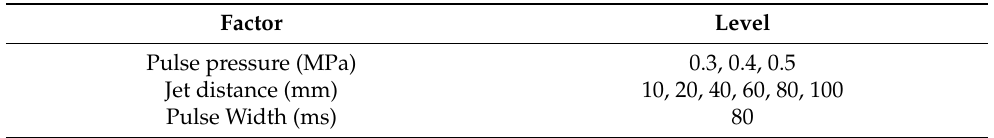
Table 1. Parameter settings of the deashing process for the four kinds of slot-type nozzles with different nozzle areas.